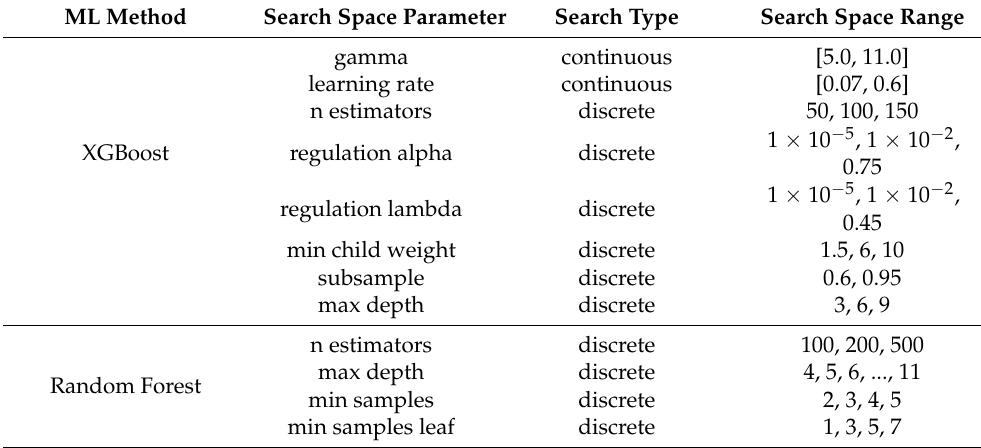
Table 2. Hyperparameter of ML